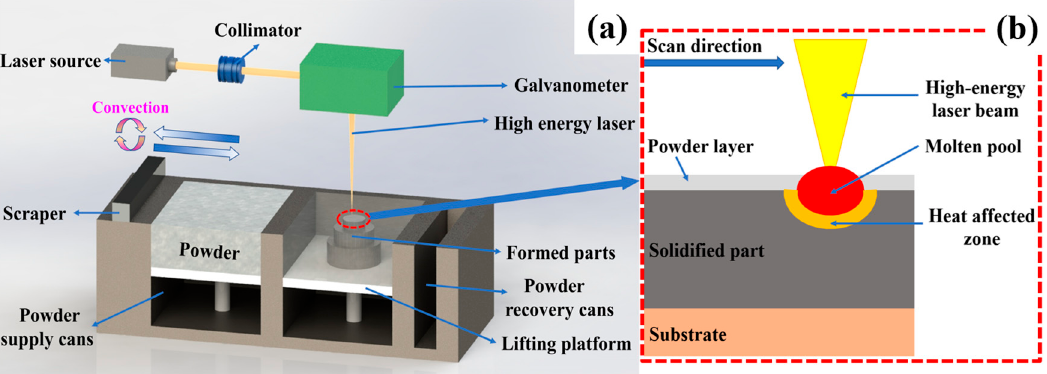
Figure 2. The SLM equipment and forming schematic diagram: ( a ) the equipment of SLM; ( b ) the schematic diagram of SLM. Reprinted with permission from Ref. [70]. Copyright 2022, copyright Shi W, Li J, Liu Y.